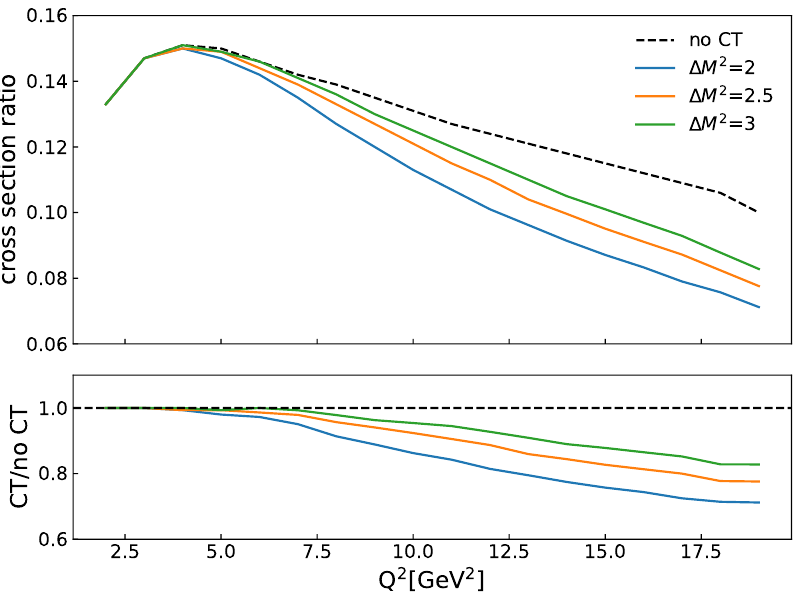
= σ ( p r = 400 MeV/ c ) / σ ( p r = 200 MeV/ c ) , in Figure 4. Predictions of cross section ratios, R theory D the D ( e , e (cid:48) p ) n reaction at α n ≈ 1 for various hypotheses of ∆ M 2 [8] that are compatible with the recent Hall C results [9]. Here, α n is the light cone momentum fraction of the nucleon as defined in Equation (7). ( Top ) predicted cross-section ratios include the effect of CT with ∆ M 2 between 2 and 3 GeV 2 . ( Bottom ) the change of cross section ratio with various ∆ M 2 values comparing to “no CT” calculations performed in the generalized eikonal approximation (GEA) framework [37,41] using the AV18 deuterium wave